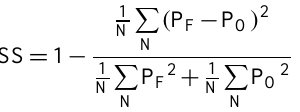
Fig. 1. Mean FSS against the spatial scale for 3h rainfall. The scale (horizontal axis) is marked by the number of grid points in the side of the square elementary area (marked by N g in the text). The mean FSS were calculated over all hourly model outputs given threshold (indicated in the legend). They were determined from raw radar data, area corrected radar data and pixel-adjusted radar data (see the legend). The label 128 on the horizontal axis marks the elementary area corresponding to the entire domain.